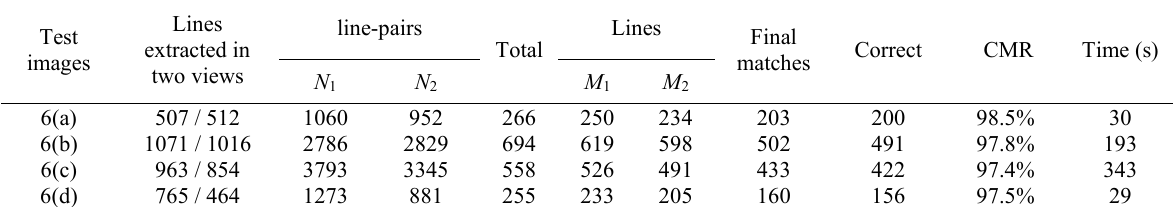
Table 1 Line matching results of our